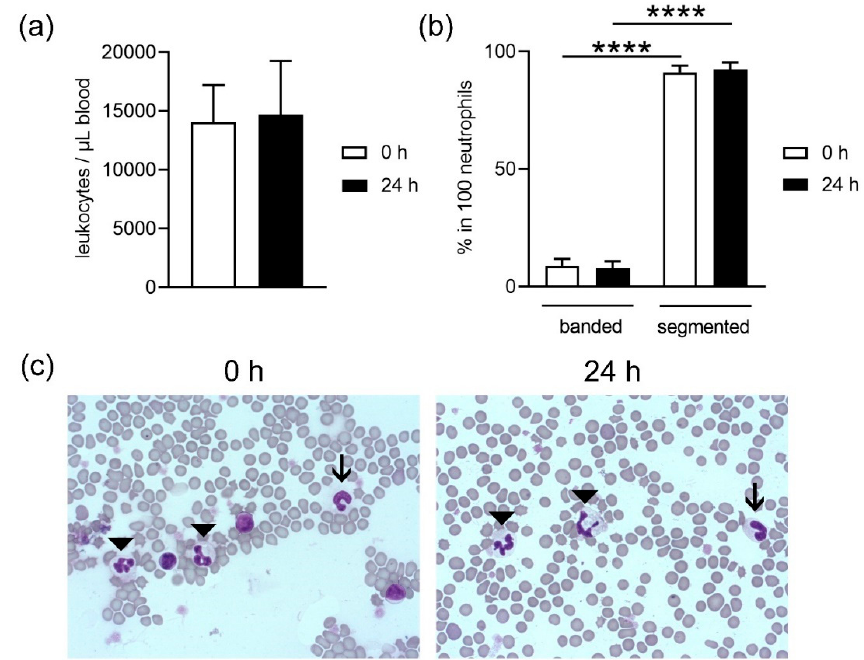
Figure 2. ( a ) No significant di ff erence in the number of leukocytes was detected in whole blood. ( b ) Amount of band and segmented neutrophils in stained blood smears. ( c ) Representative images show the morphology of neutrophils in fresh (0 h) and stored blood (24 h) after HAEMA fast stain (band = arrow, segmented = arrowhead). The images were captured with a Zeiss Axio Imager M2 microscope and taken with a 63 × objective. Data in a and b were analyzed with one-tailed paired Student’s t -test ( n = 9) and presented with mean ± SD (**** p <